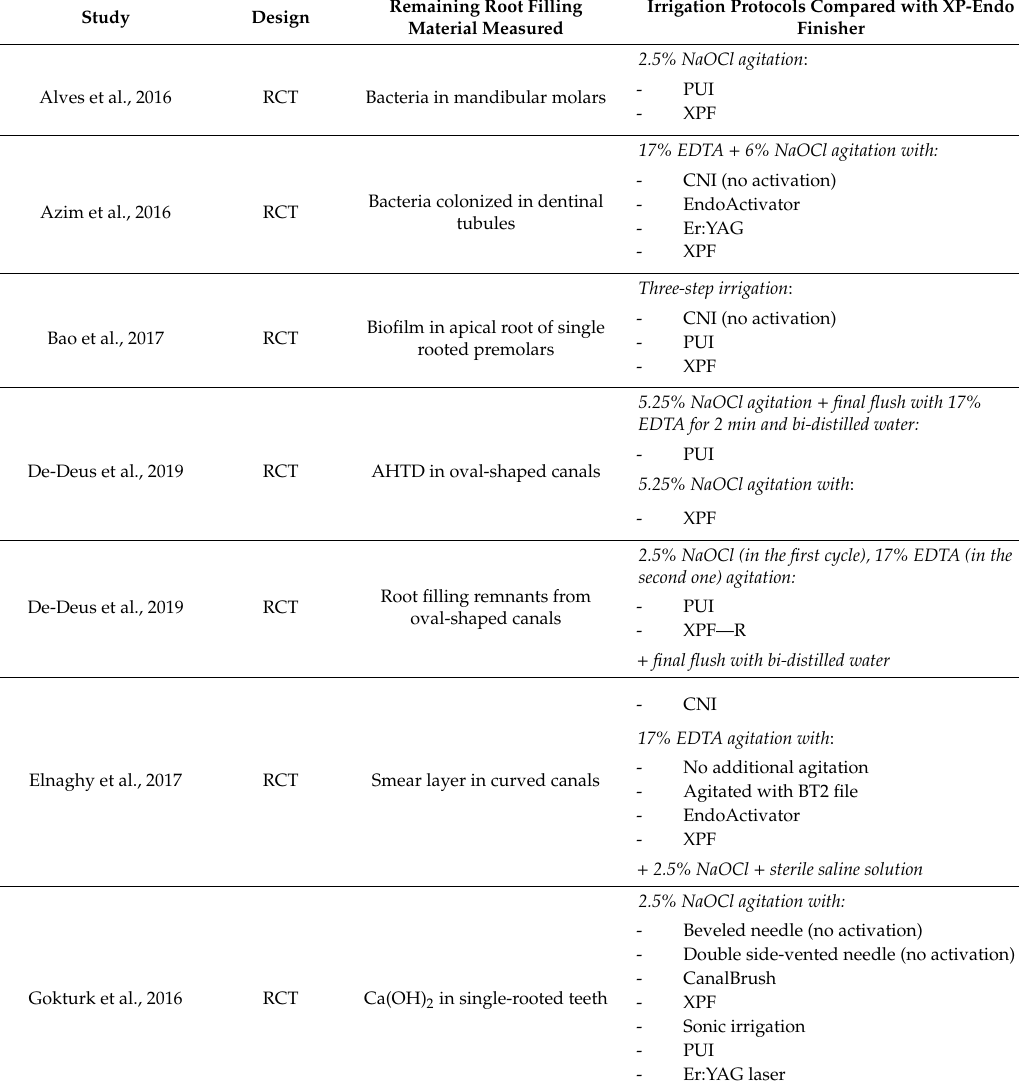
Table 2. List of included